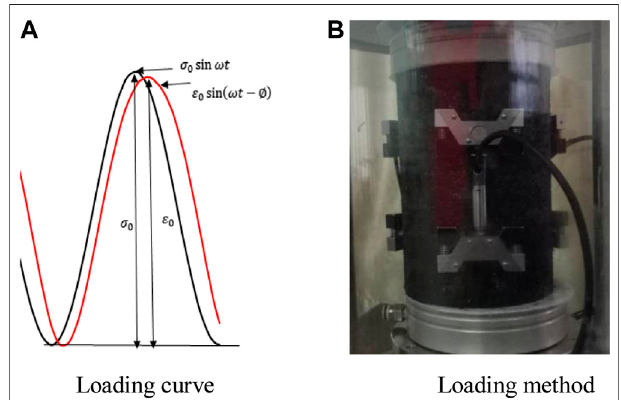
FIGURE 1 | Dynamic modulus